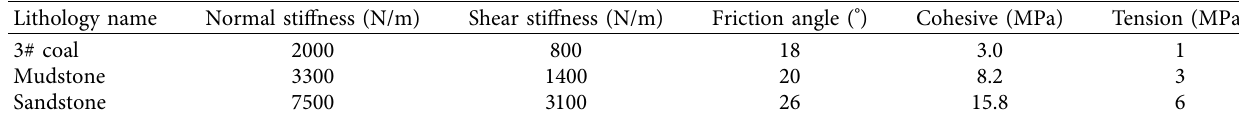
Table 3: Mechanical parameters of joints.